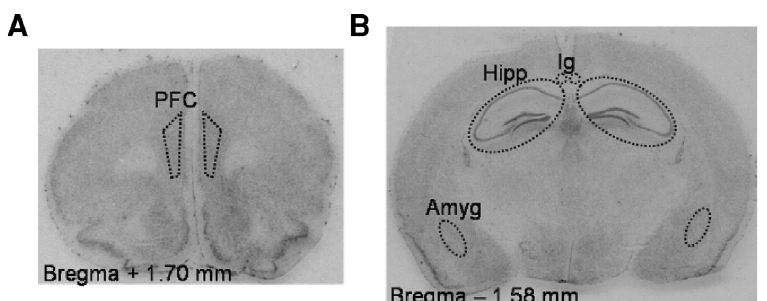
Figure 1. Coronal sections of the mouse brain, stained with cresylviolet. Dotted lines indicate the areas of interest for image analysis of optical density for MR and GR mRNA expression. ( A ) the infra- and prelimbic areas of the prefrontal cortex (PFC), ( B ) the hippocampus (Hipp), amygdala (Amyg) and indusium griseum